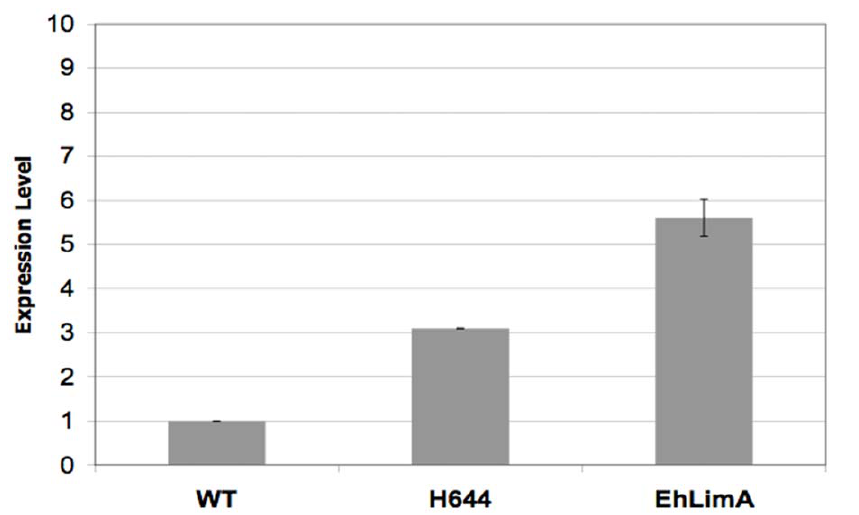
Figure 4. qPCR confirms over-expression of H644 and EhLimA. RNA from untransfected (wild-type; WT) log phase E. histolytica trophozoites or from trophozoites transfected with an expression vector encoding H644 or EhLimA was used for qPCR analysis of expression. The ssRNA gene was used as a loading control. H644 and EhLimA were expressed at approximately 3.1 ( 6 0.0)- and 5.6 ( 6 0.4)-fold, respectively, over wild-type levels.